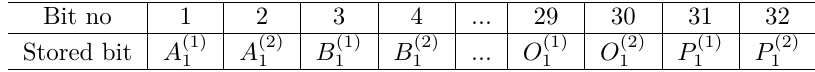
Table 5: 2-share block-wise share-slicing